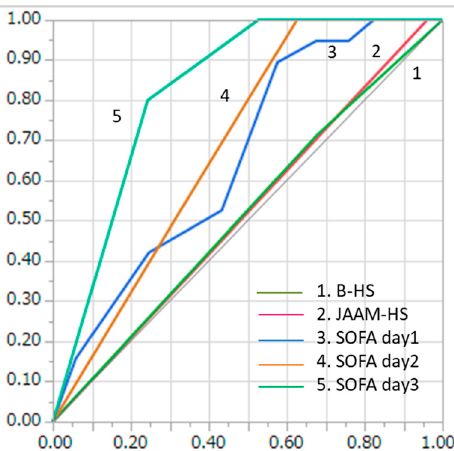
Figure 2. Comparison of AUC for in-hospital mortality between the B-HS and JAAM-HS patients.